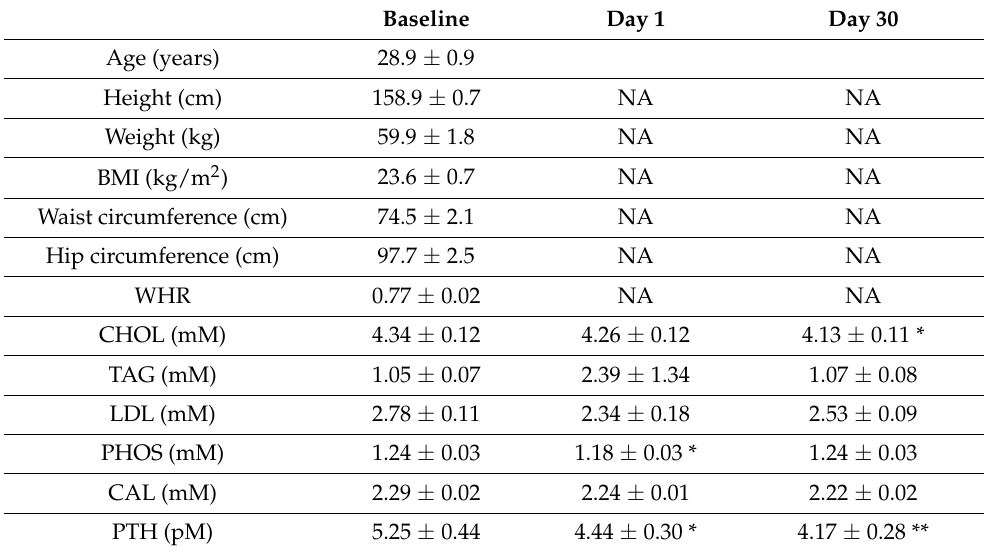
Table 1. Demographic and clinical characteristics of study participants at baseline, day 1 and day 30 following a single high dose of vitamin D 3 supplementation (n =